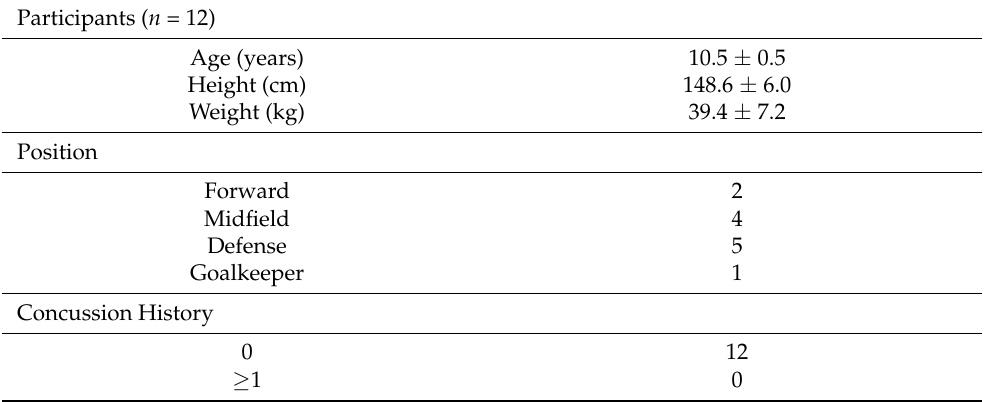
Table 2. Participant Demographics, Player Position, and Concussion History.